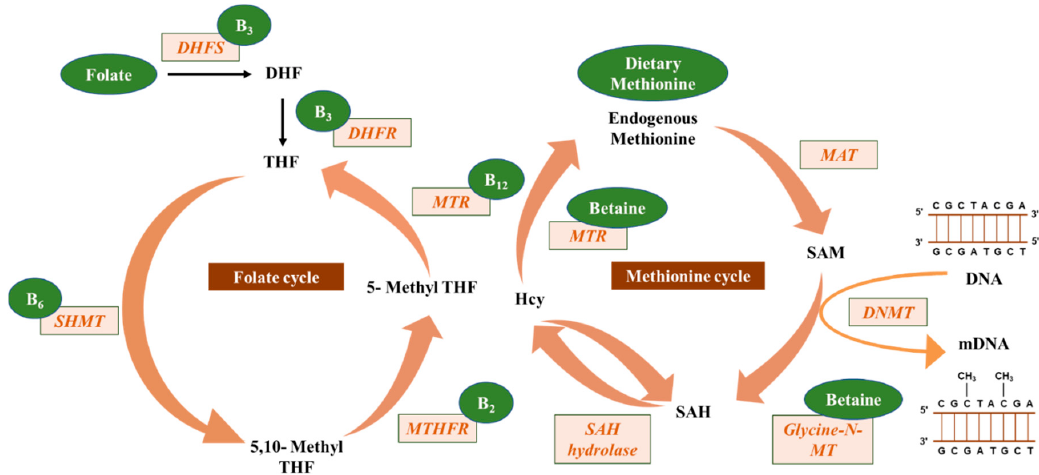
Figure 1. Micronutrient methyl donors that are involved in the one carbon metabolism and subsequently in DNA methylation. Dietary folate is converted to dihydrofolate (DHF) via the dihydrofolate synthase (DHFS) enzyme then to tetrahydrofolate (THF) by the dihydrofolate reductase (DHFR) enzyme; in both steps, vitamin B 3 (B 3 ) acts as a co-factor. THF is then converted to 5,10-methyl THF via the enzyme serine hydroxymethyltransferase (SHMT) that has vitamin B 6 (B 6 ) as a coenzyme. This reaction is followed by a reduction of 5,10-methyl THF to 5-methyl THF via the enzyme methylenetetrahydrofolate reductase (MTHFR) and the co-enzyme, vitamin B 2 (B 2 ). At the end of this cycle, 5-methyl THF is transformed back to THF by the enzyme 5-methyltetrahydrofolate-homocysteine methyltransferase (MTR) that utilizes vitamin B 2 as a co-enzyme. The same enzyme, MTR, converts homocysteine (Hcy) to methionine. Betaine acts as an indirect methyl donor for the latter reaction. Methionine, whether it is endogenously synthesized or diet-derived is critical for the synthesis of S-adenosylmethionine (SAM), which acts as a DNA methyltransferase (DNMT) cofactor and a universal methyl-donor for DNA methylation. The enzyme that catalyzes this reaction is methionine adenosyltransferase (MAT). Glycine N-methyltransferase (Glycine N-MT) converts SAM to s-adenosylhomocysteine (SAH), which could be reversibly converted to Hcy via the enzyme SAH hydrolase. Finally, the activated DNMT enzyme will catalyze the transfer of a methyl group to carbon 5 of cytosines in the DNA to produce methylated DNA (mDNA).